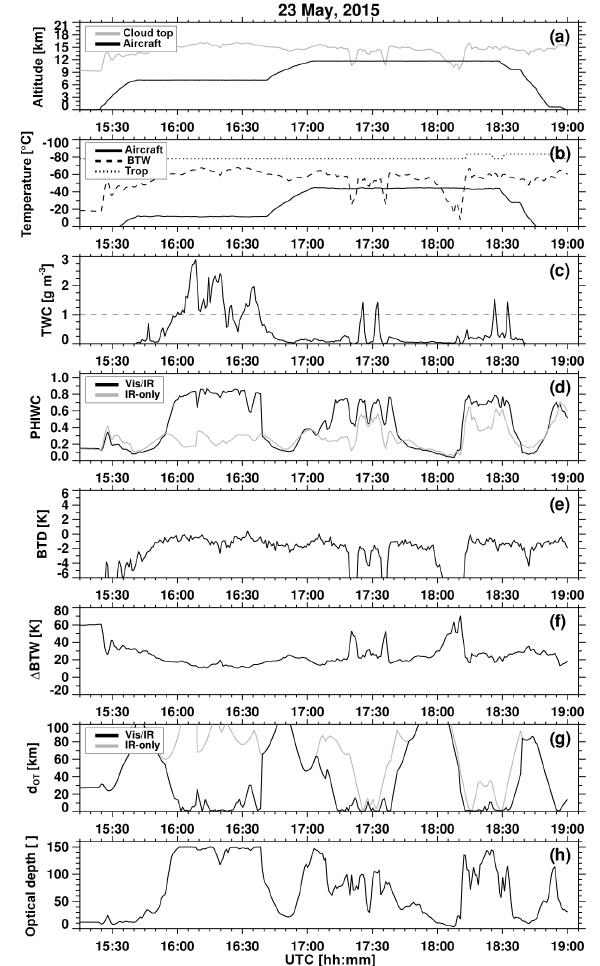
Figure 11. Time series of matched aircraft and satellite observations for Flight 5 of the Florida-2015 campaign on 19 August 2015. The panels are the same as those described for Fig.